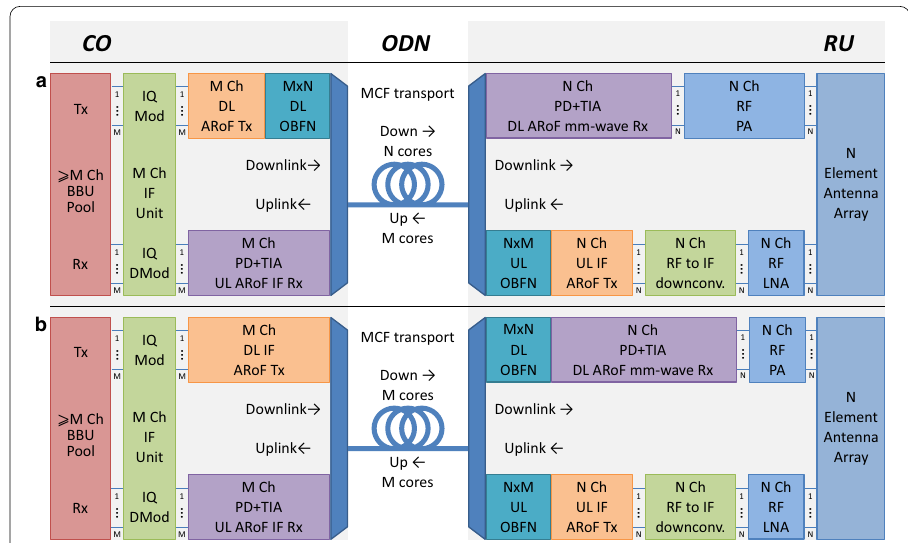
Fig. 1 blueSPACE ARoF fronthaul architecture with optical beamforming in both DL and UL: a with DL OBFN at the RU, avoiding signal synchronization issues, but requiring N -core MCF DL, b with DL OBFN placed at the CO and symmetric M -core DL and UL MCF transport. CO: central office, ODN: optical distribution network, RU: remote unit, BBU: baseband unit, IQ: in-phase and quadrature, IF: intermediate frequency, RF: radio frequency, ARoF: analog radio-over-fiber, DL: downlink, UL: uplink, MCF: multi-core fiber, PD: photodiode, TIA: transimpedance amplifier, OBFN: optical beamforming network, PA: power amplifier, LNA: low-noise